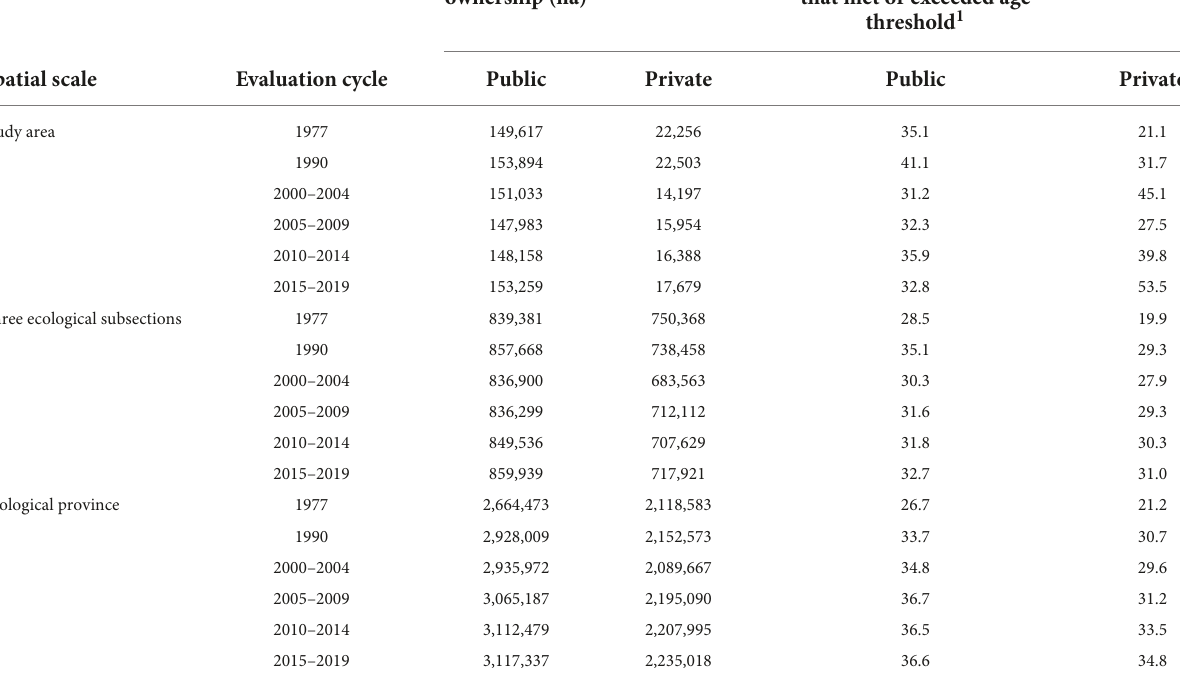
TABLE 1 The estimated area (ha) of land in public and private ownership overall and percentage of land in these ownership classes that meet or exceed the age threshold in which cavities suitable for nesting wood ducks are likely to occur in the forested portion of Minnesota during six forest inventory and analysis evaluation